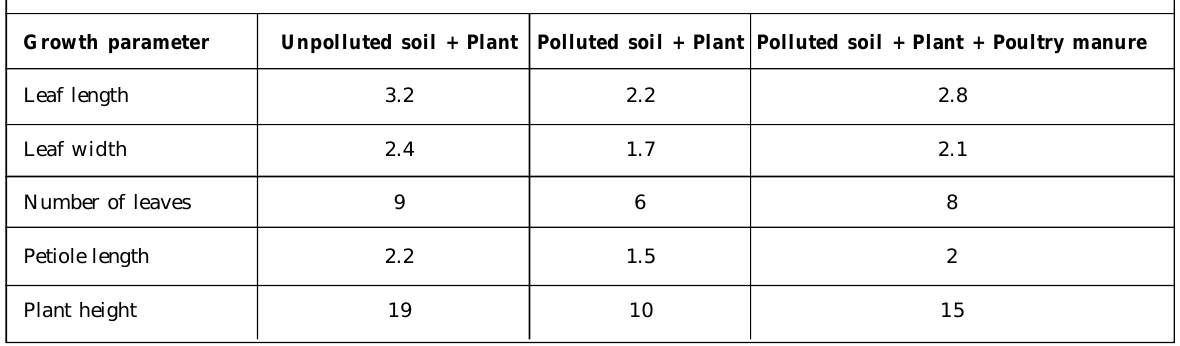
Table 2: Effect of poultry manure on growth characteristics of Vigna unguiculata (cowpea) plant in used motor oil polluted soil Growth